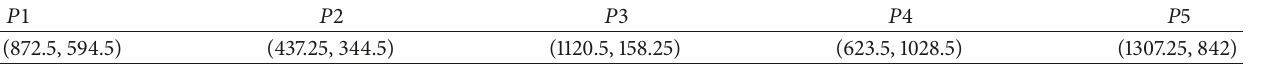
Table 1: Industrial camera’s raw data of position